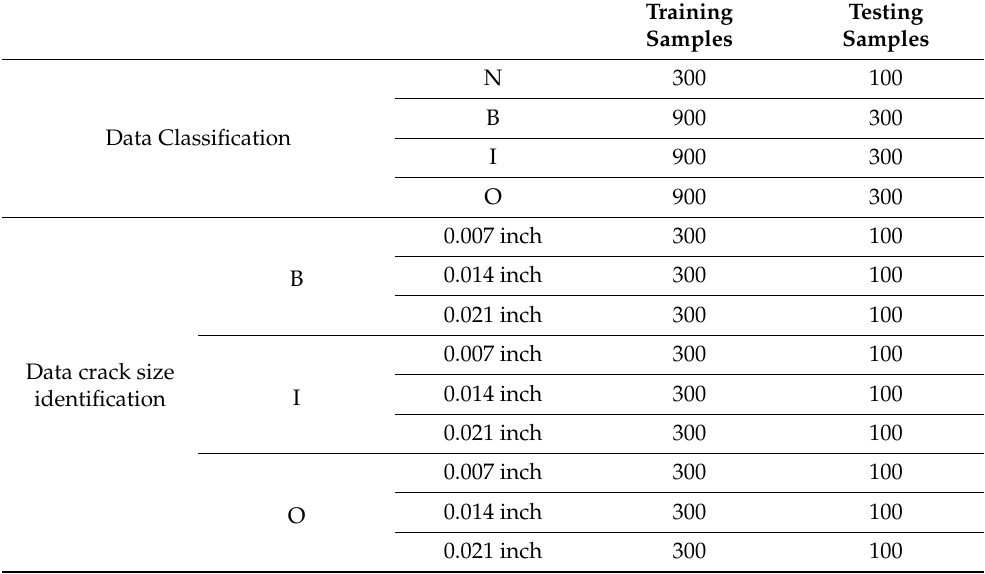
Table 4. Training and testing RMS residual